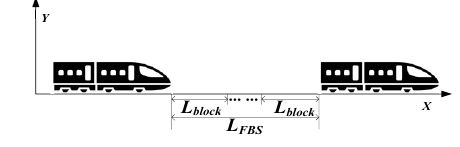
Figure 1 Fixed-block